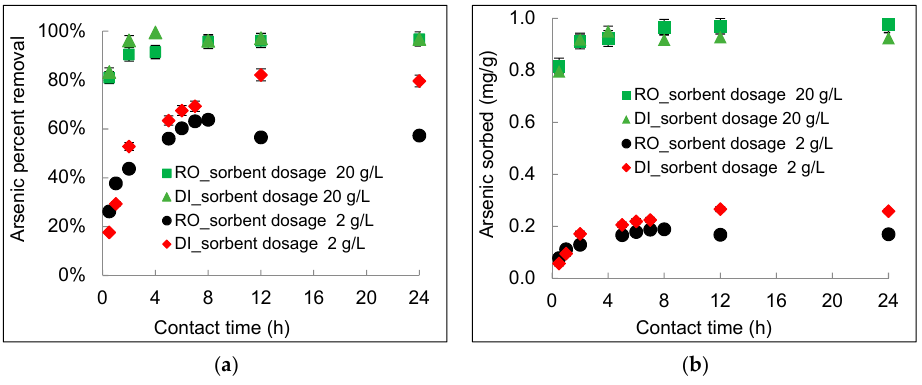
Figure 2. Effect of contact time on arsenic removal using DWTS. ( a ) Arsenic percentage removal; ( b ) Amount of arsenic sorbed. The error bars represent the standard deviation of duplicate testing results.